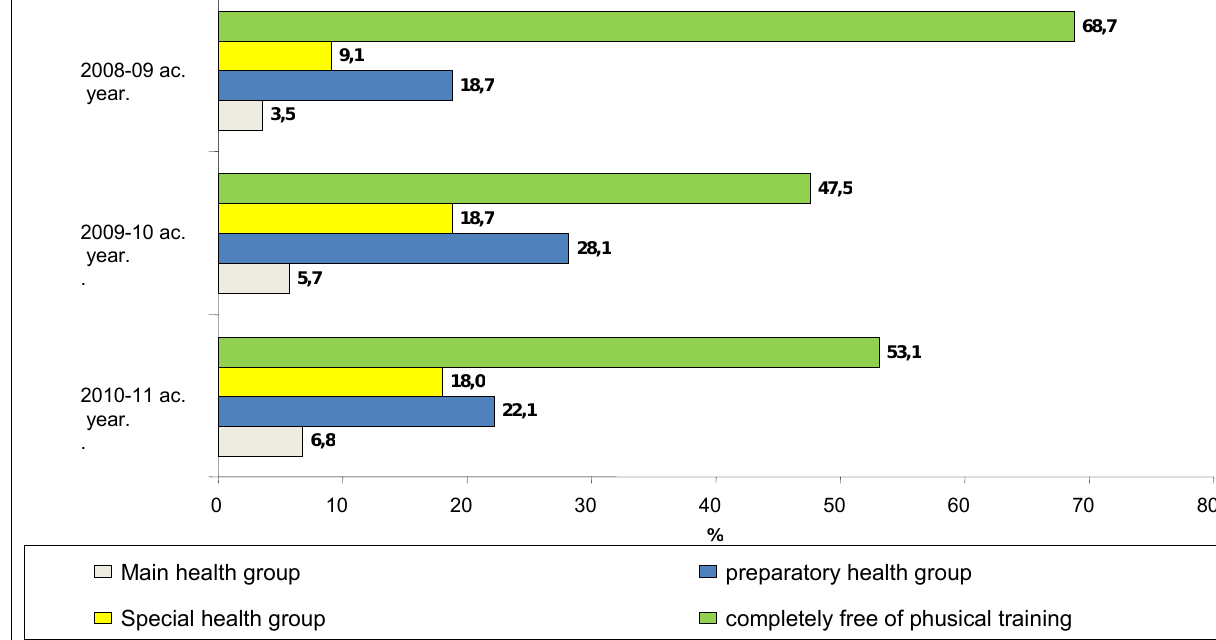
Fig.1 Distribution of Belgorod SRUSU students by health groups in 2008-2011.